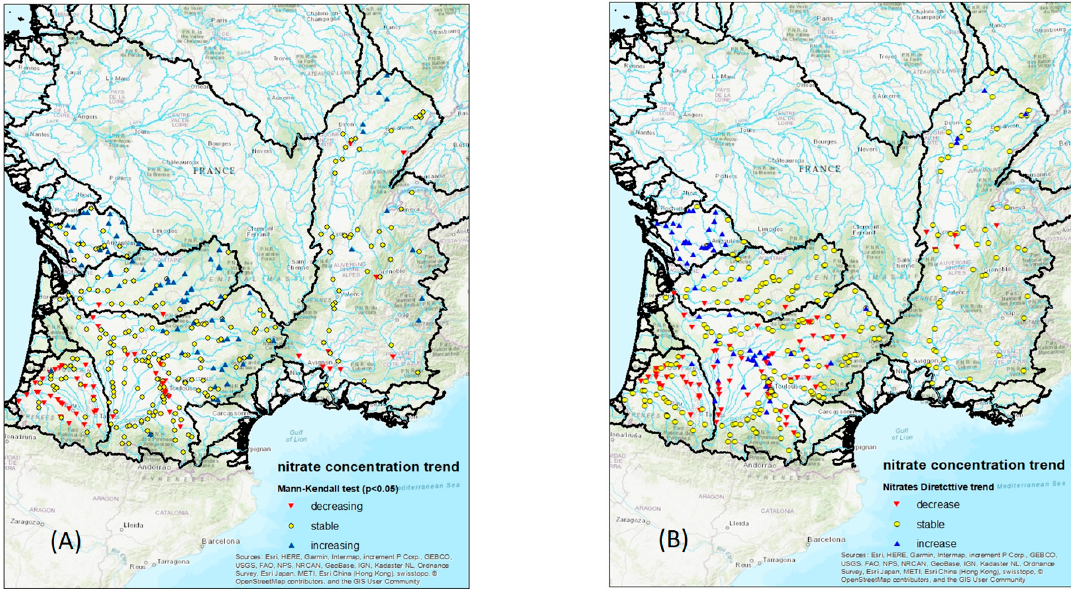
Figure 5. Trend analysis of the mean annual nitrate concentration using the Mann–Kendall ( A ) and the Nitrates Directive ( B ) approaches for the entire water quality dataset using the raw